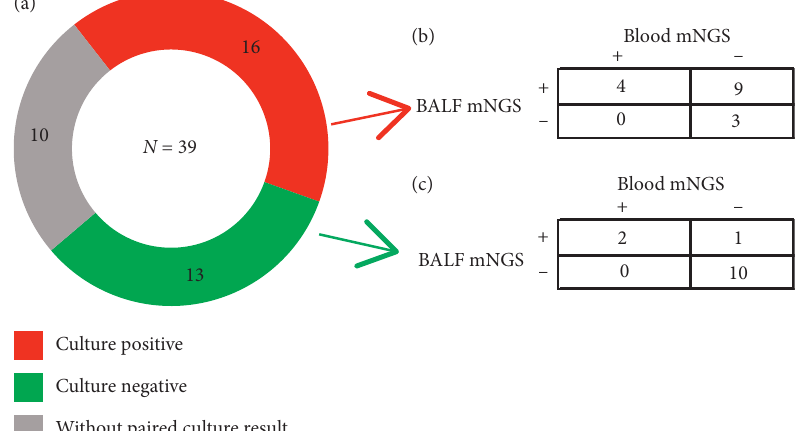
Figure 1: Blood and BALF mNGS for bacteria and fungi pathogen identification. (a) The culture results in 39 patients. 16 patients had positive culture results, shown in red; 13 patients had negative results, shown in green; the remaining 10 patients had no paired culture results which were sampled simultaneously with mNGS, shown in grey. (b) Pathogen identification of BALF and blood mNGS in patients with positive culture results. The sensitivity of the BALF mNGS and blood mNGS was (13/16 � 81.3%) and (4/16 � 25.0%), respectively. (c) Pathogen identification of BALF and Blood mNGS in patients with negative culture results. The specificity of the BALF mNGS and blood mNGS was (10/13 � 76.9%) and (11/13 � 84.6%), respectively. Abbreviations: mNGS, metagenomic next-generation sequencing; BALF, bronchoalveolar lavage